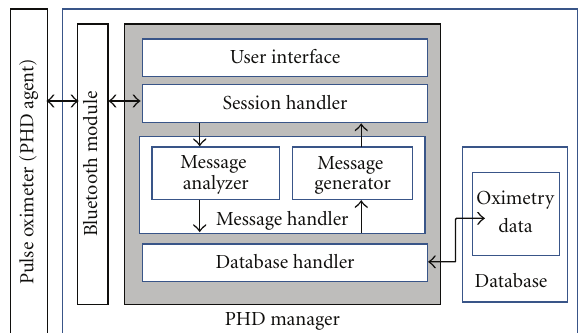
Figure 5: Architecture of PHD manager.